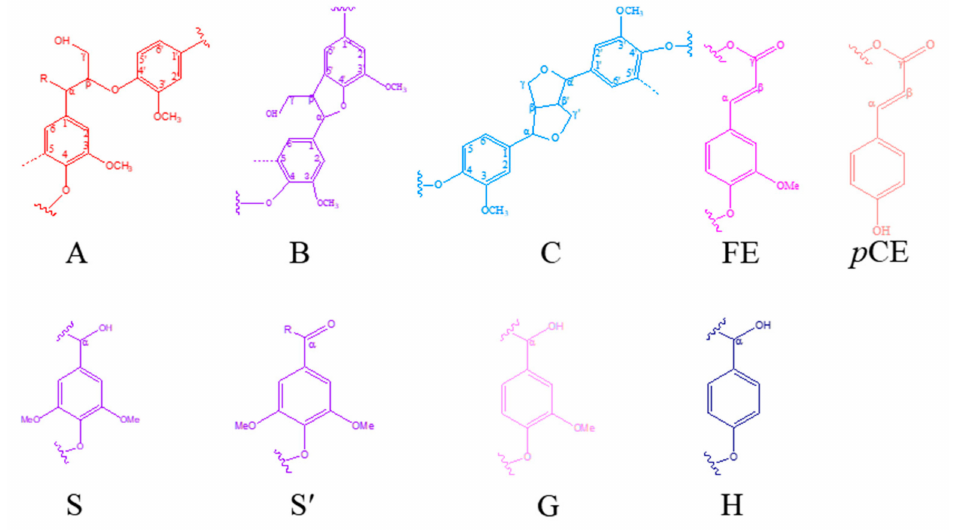
Figure 3. Main interunit linkages and aromatic units of lignin: ( A ) β -O-4 (cid:48) , ( B ) β -5 (cid:48) , ( C ) β - β (cid:48) , ( FE ) ferulate ester, ( p CE ) p -coumarate ester, ( S ) syringyl units, ( S (cid:48) ) C α -oxidized syringyl unit, ( G ) guaiacyl unit, ( H ) p -hydroxyphenyl unit.